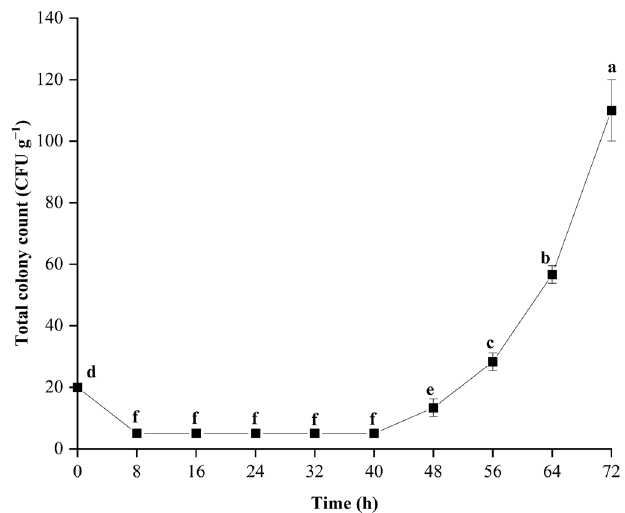
Figure 2. Fitting curve of C. fimbriata growth, showing the count of colony-forming units over time. The bars represent the standard deviations ( ± SD) of three independent measurements. Different lowercase letters represent significant differences according to Duncan’s multiple range test ( p < 0.05).